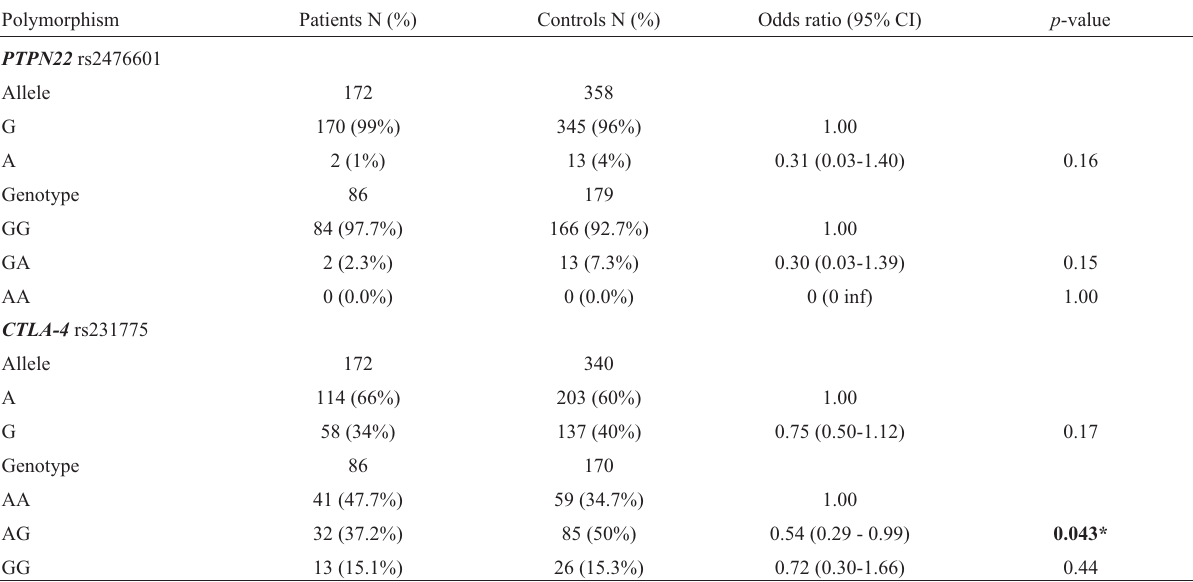
Table 2 - Genotype and allele distribution of PTPN22 and CTLA-4 gene polymorphisms in TS and controls group.